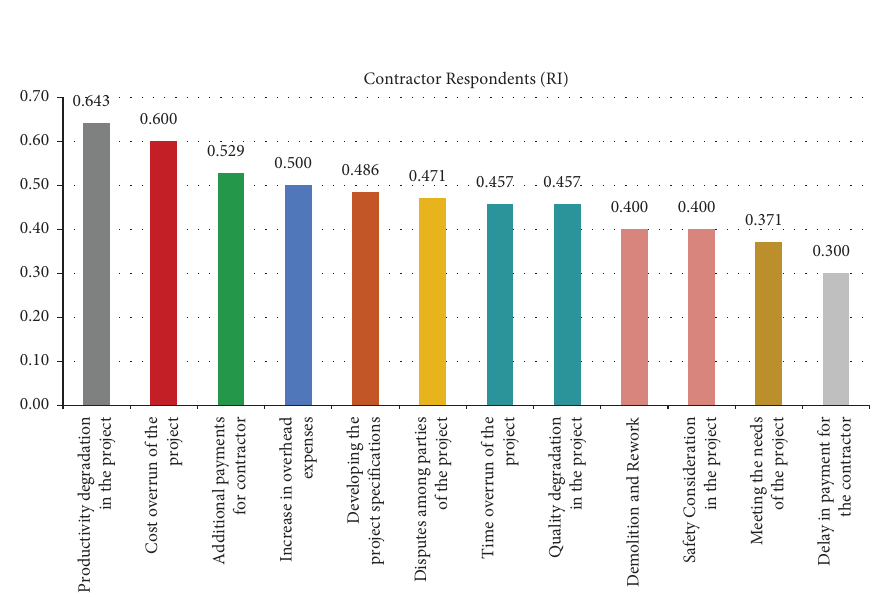
Figure 3: Frequency of impact of change orders on projects (contractors’ responses).